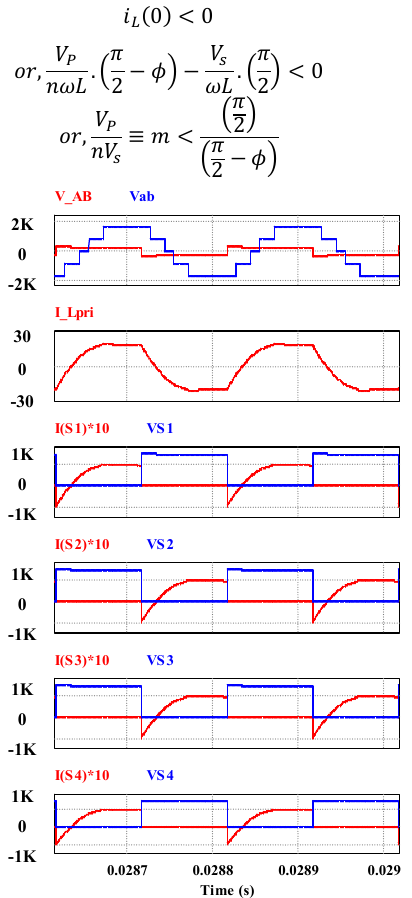
Figure 12. Voltage across the transformer (cid:1874) currents and voltages for (cid:1845)